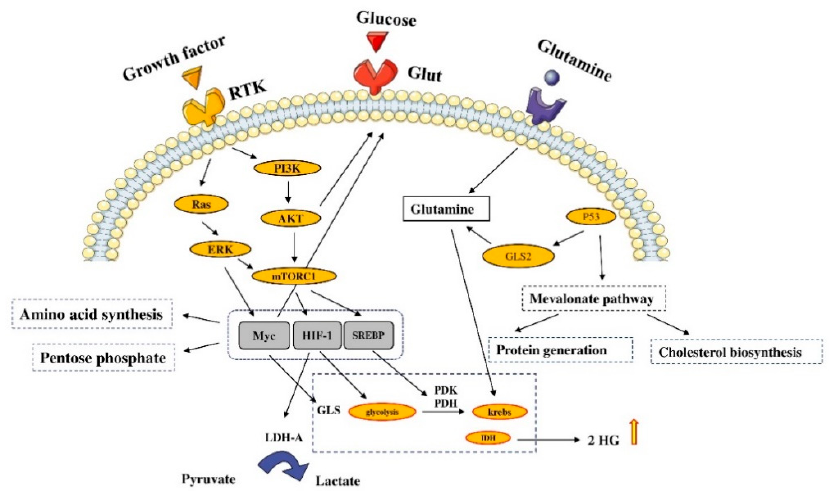
Figure 3. Signaling pathways and cell metabolism. Metabolism dysregulation is a common phe- nomenon in cancer cells. Different mutations, such as isocitrate dehydrogenase 1 (IDH1) and 2 (IDH2) mutations, can lead to the increased survival of cancer cells. The figure was produced using Servier Medical Art (http://smart.servier.com/) (assessed on 2 January 2020).